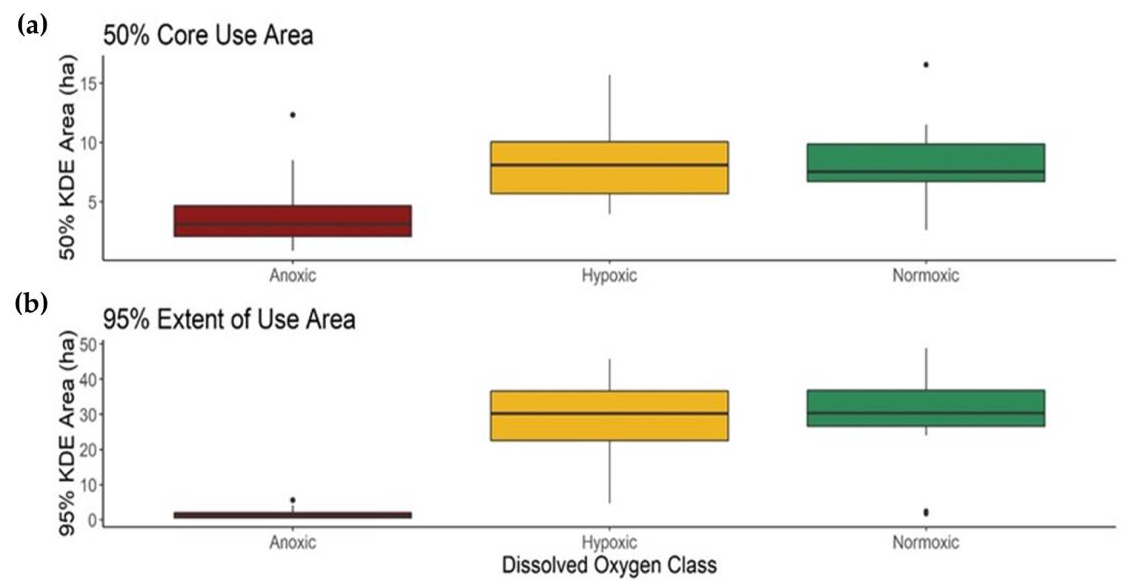
Figure 5. Fish habitat use area was reduced in periods of anoxia; ( a ) Boxplots represent range and median values and quartiles (5th, 25th, 75th, and 95th) of fish core use (50% KDE) area (ha) per dissolved oxygen concentration class. Dots represent outliers. ( b ) Range and median values and quartiles (5th, 25th, 75th, and 95th) for fish extent of use (95% KDE) area (ha) per dissolved oxygen concentration class.